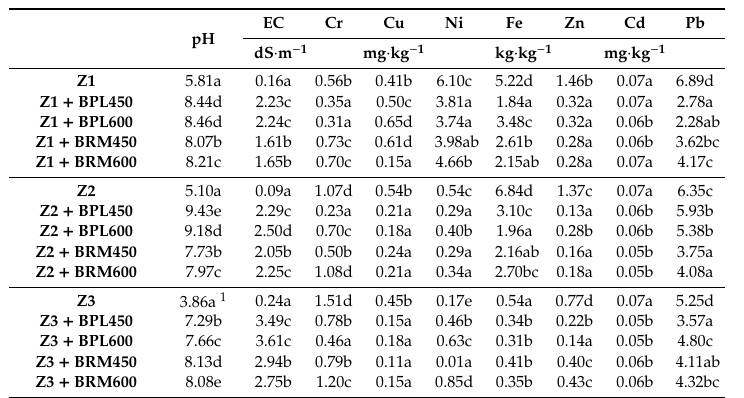
Table 4. pH, Electrical conductivity (EC), and mobile metal content in control soils and biochar / soil mixtures from Zarandas area after 180 incubation days.